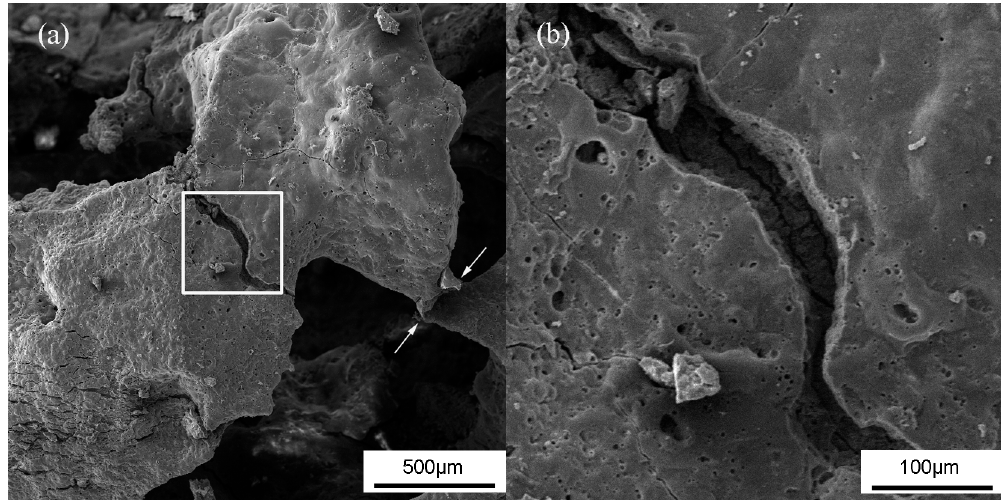
Figure 13. SEM image of the deformation of a foam strut: ( a ), and magnification ( b ) at 200 °C.